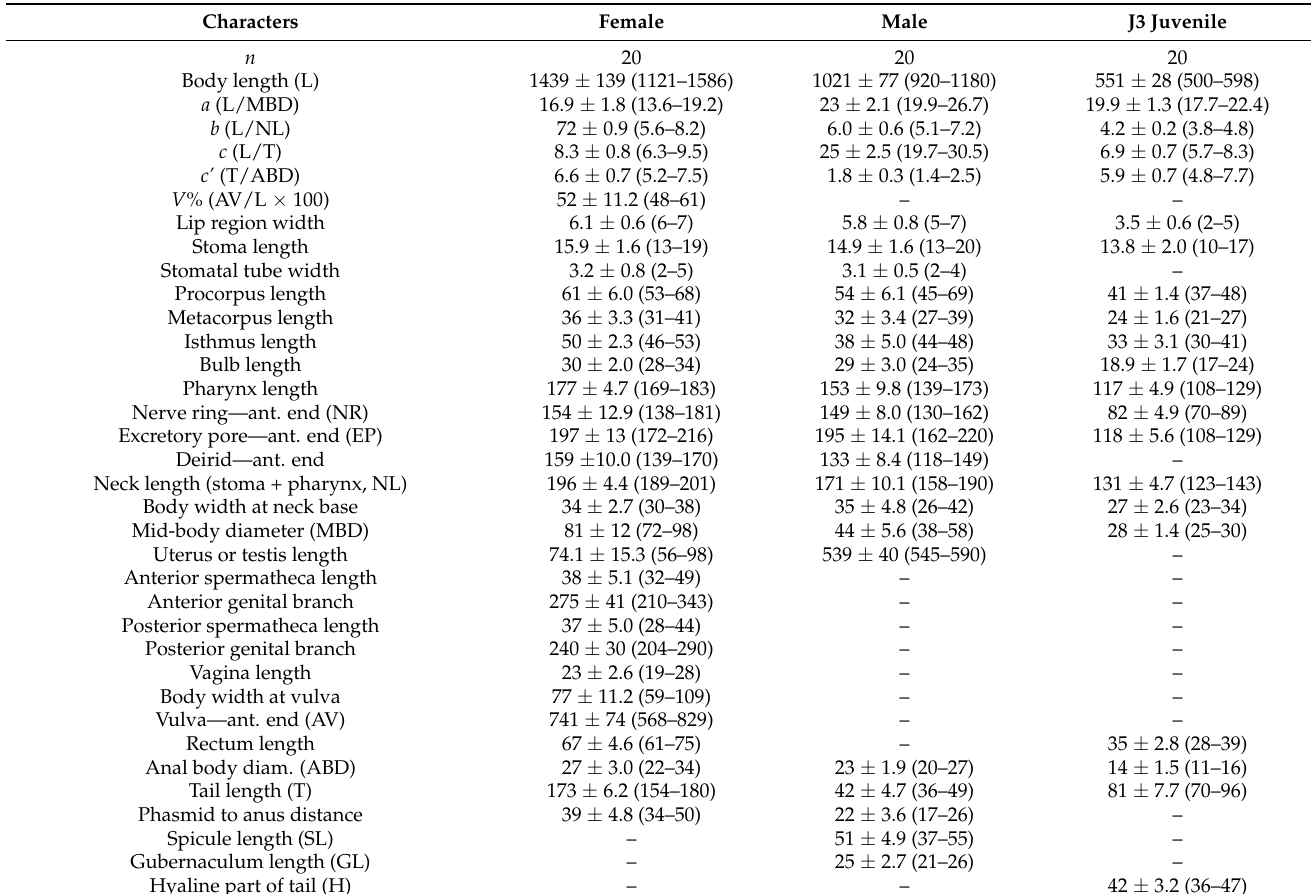
Table 2. Morphometrics of Oscheius siddiqii Tabassum and Shahina, 2010 (isolation CS43). All measurements are in µ m (except n , ratio and percentage) and in the form of mean ± SD